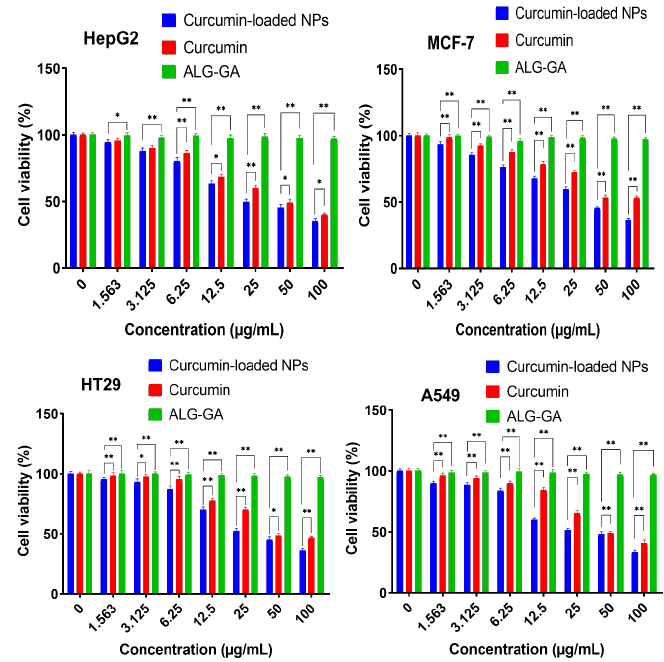
Figure 9. Cytotoxicity activity of Curcumin and curcumin-loaded NPs at different concentrations exposed to cancer cell lines (MCF7, HepG2, A549, and HT29) after 48 h. Mean ± SD of three experiments. Error bar are * p < 0.05, ** p < 0.01.